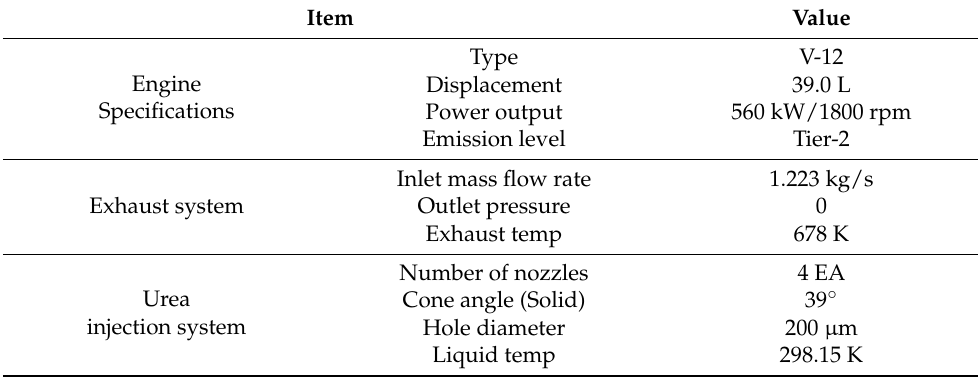
Table 2. Boundary conditions for CFD analysis [17].